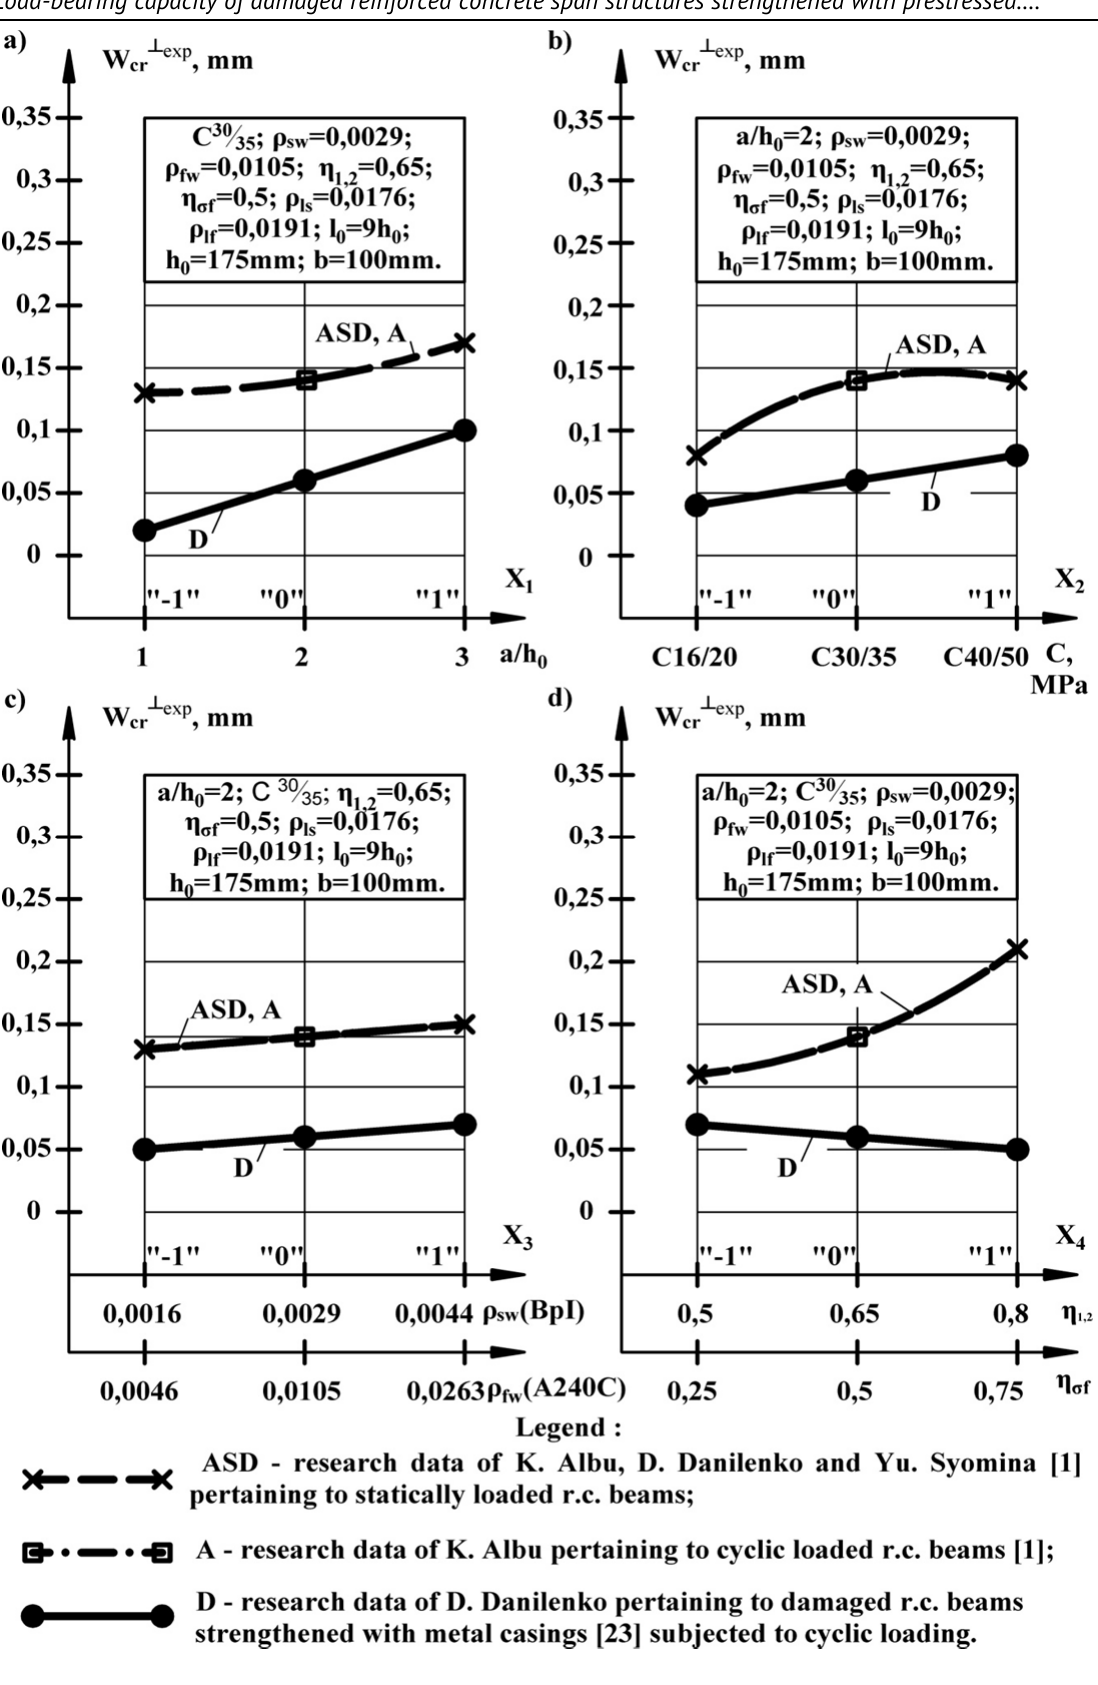
Figure 3. Impact of the relative shear span ( а ), concrete grade (b), quantity of the transverse reinforcement (c), levels of the transverse loading and prestress of the metal casing elements (d) on the normal crack width in the tested beams prior to their